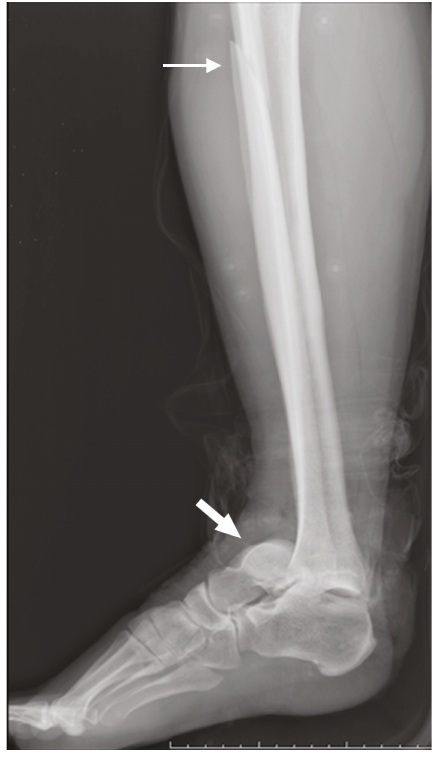
Figure 2: Lateral radiograph of the right shin and foot. Anterior dislocation of the talus (thick white arrow) and proximal fi bular fracture (thin white arrow) are